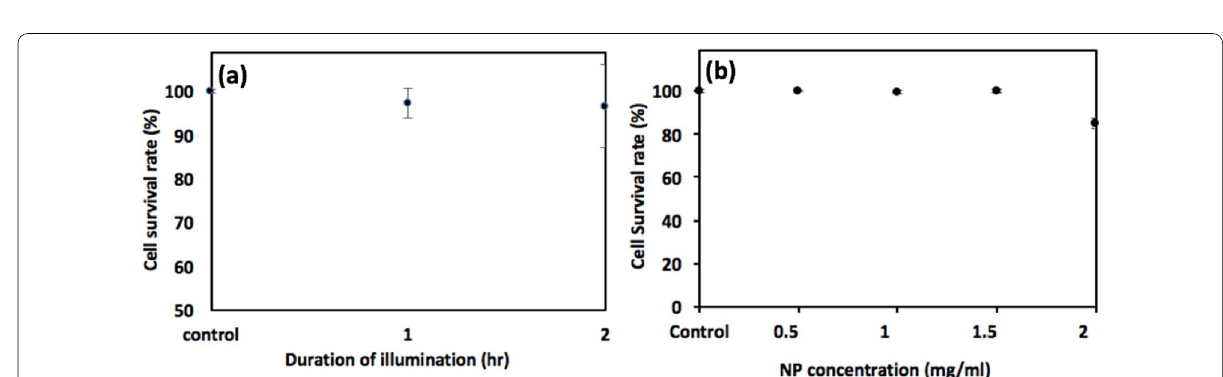
Fig. 4 Cytotoxicity assay of experimental parameters. The survival rate of HepG2 cells when dosed with a the duration of NIR irradiation, b 120‑nm NPs of various concentration are presented. The duration of NP incubation was one day; the standard deviation of three experimental trials ( N for each data point is